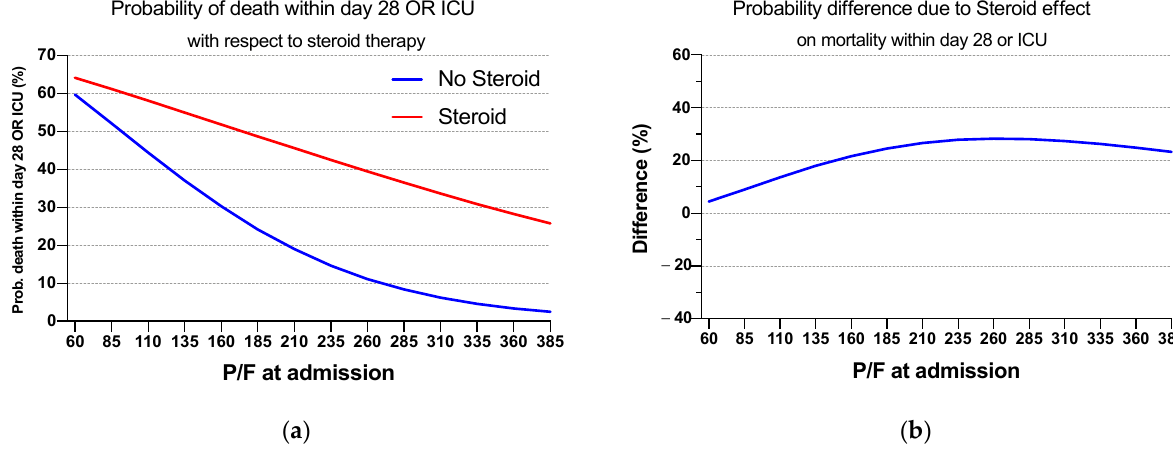
Figure 3. ( a ) Estimated probability of death within 28 days or ICU with respect to P/F values and steroid therapy. ( b ) Estimated difference in mortality within 28 days or ICU admission between exposed and unexposed cohort. Light blue shaded area shows confidence interval.